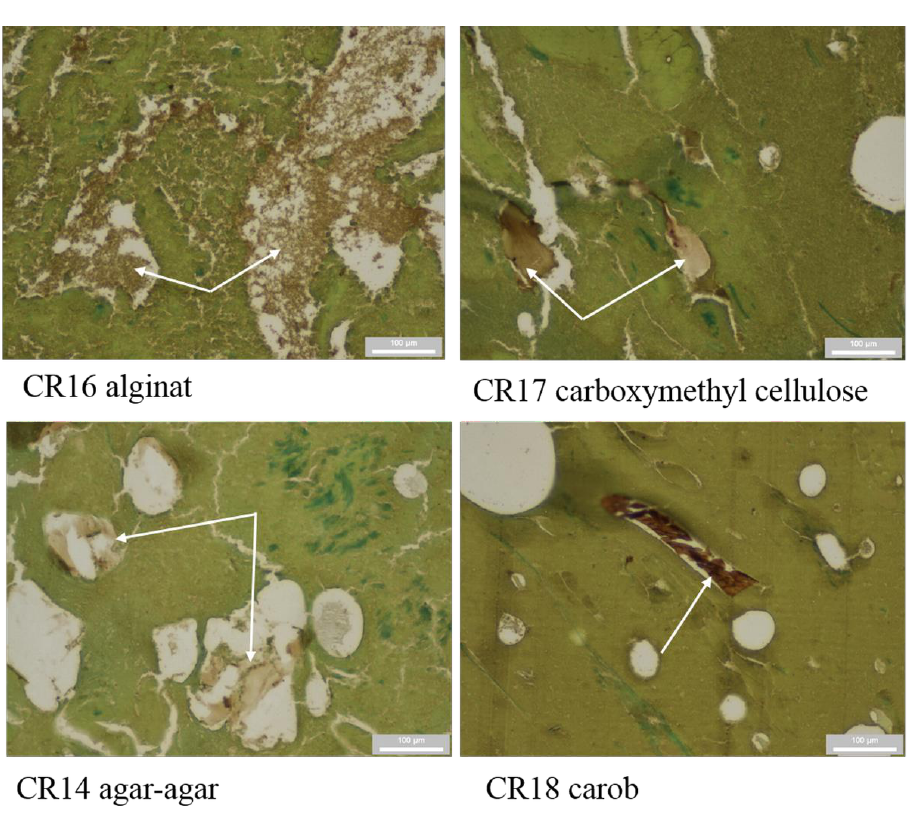
Figure 2. Structure of alginate, carboxymethyl cellulose, agar-agar, and carob (arrows).